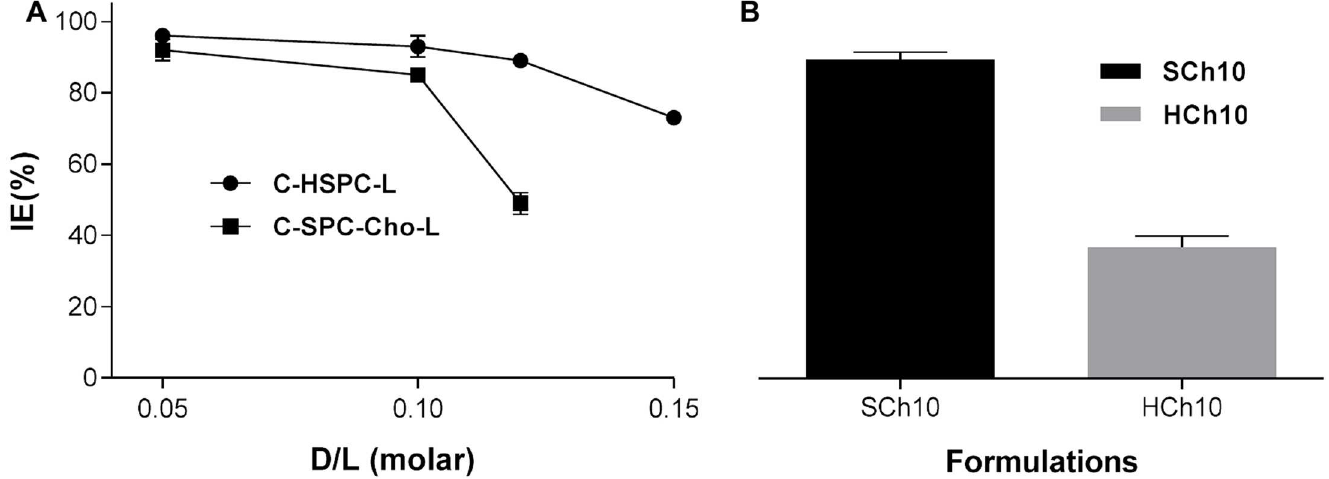
Fig 2. Incorporation efficiency (IE) of Cur in different liposome-types (A). Comparisonof the incorporation efficiency betweenC-HSPC-Cho-L (HCh10) and C-SPC-Cho-L (SCh10) formulations when 10% molar of Cur was added (B). The results are shown as the mean ± SD of three replicates.